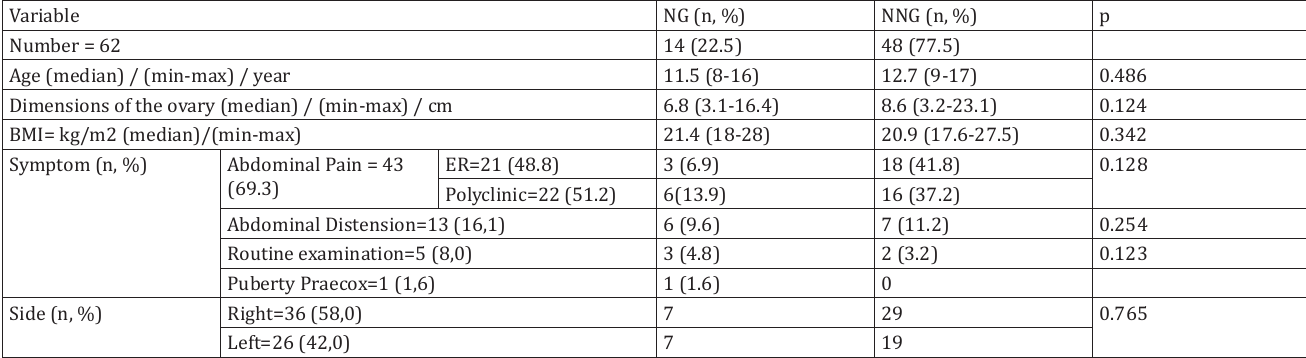
Distribution of demographic features and symptoms